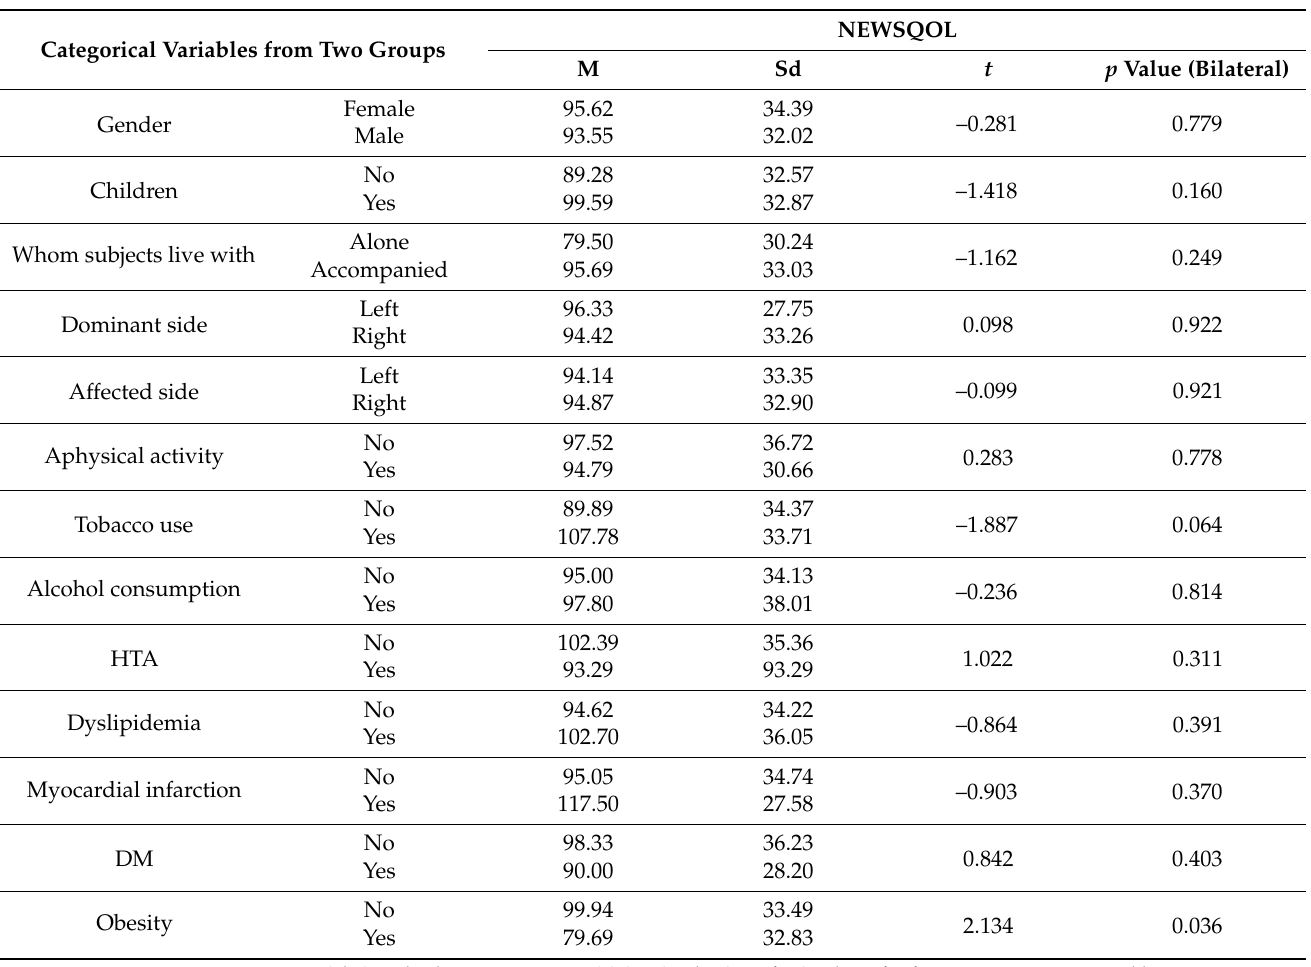
Table 5. Differences between independent study variables of two groups in quality of life using student’s t for independent